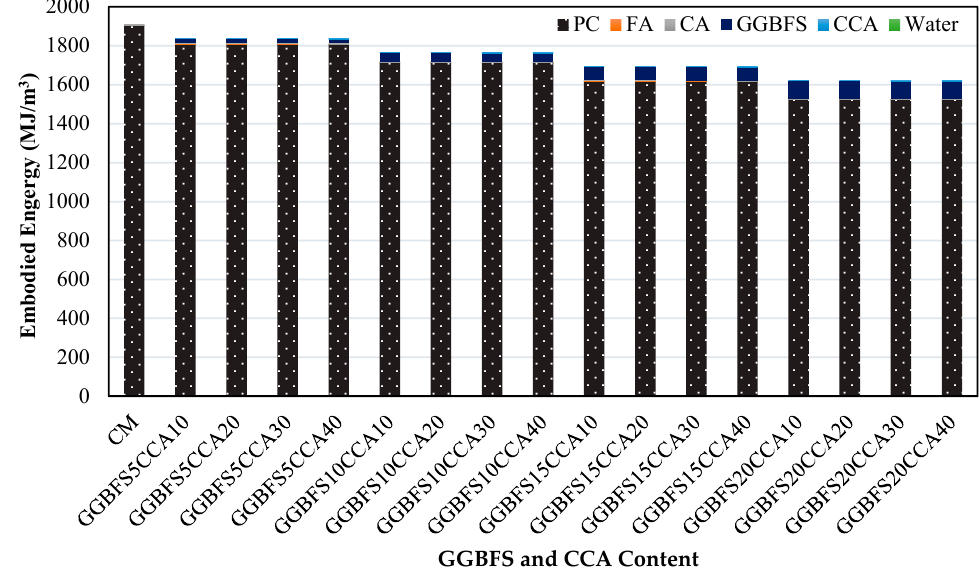
Figure 19. Embodied energy of concrete blended with GGBFS along with CCA.